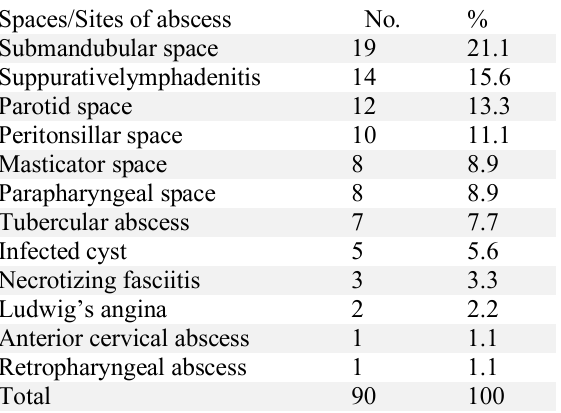
Spaces/Sites of